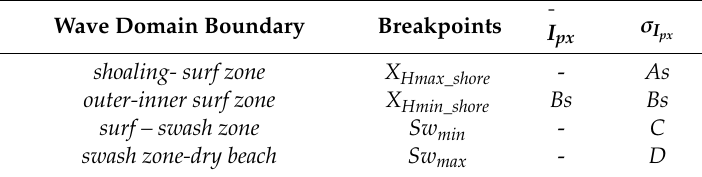
plot (see Figure px